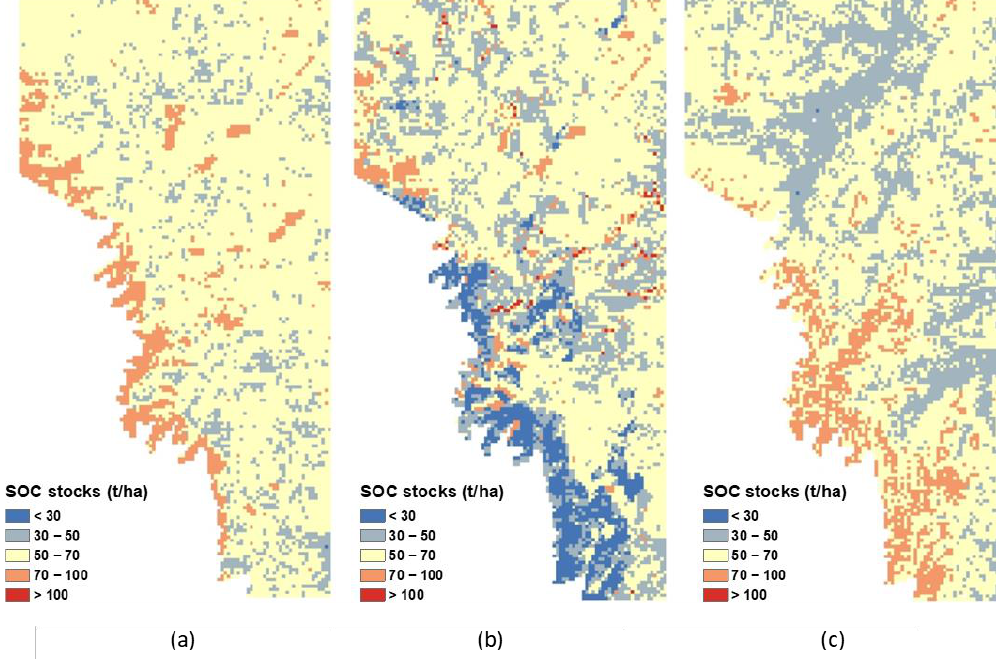
Figure 7. The predicted spatial distribution of SOC stocks in the 0–30 cm soil layer in 2016 by the ( a ) model without soil redistribution, ( b ) model with soil redistribution and ( c ) Cubist regression model.